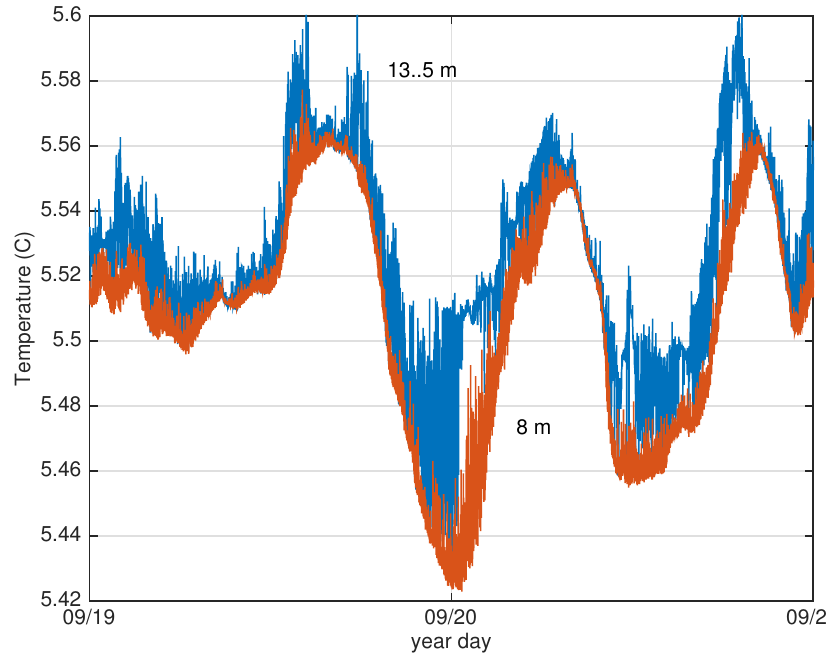
Figure 6. Time series for the bottom 2 SBE temperature sensors. High frequency variability is modulated on internal swash band time scales.